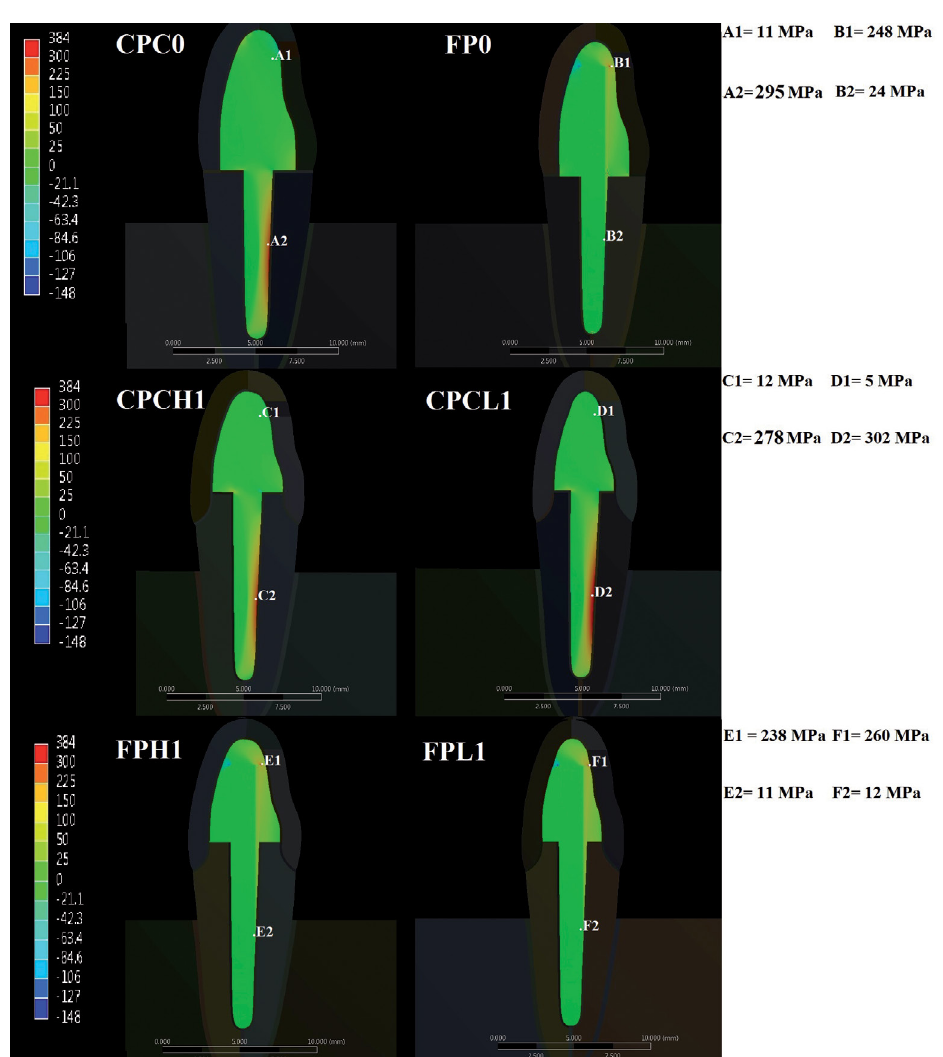
Figure 7- Images above show: higher values of tension stress at resin composite cores, in comparison with groups restored with cast post and cores (Fiber Post – FP0, Fiber Post higher than 1 mm – FPH1, Fiber Post lower than 1 mm – FPL1); higher values of tensile stress at internal root portion in groups restored with cast post and cores, in comparison with groups restored with fiber post (Cast Post and Core – CPC0, Cast Post and Core higher than 1 mm – CPCH1, Cast Post and Core lower than 1 mm –